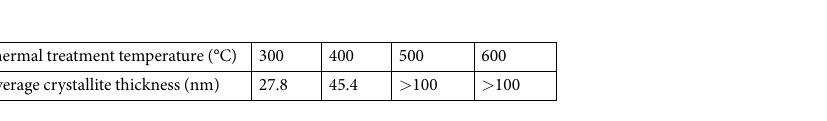
Table 1. Average crystallite thicknesses of synthesized MoO 3